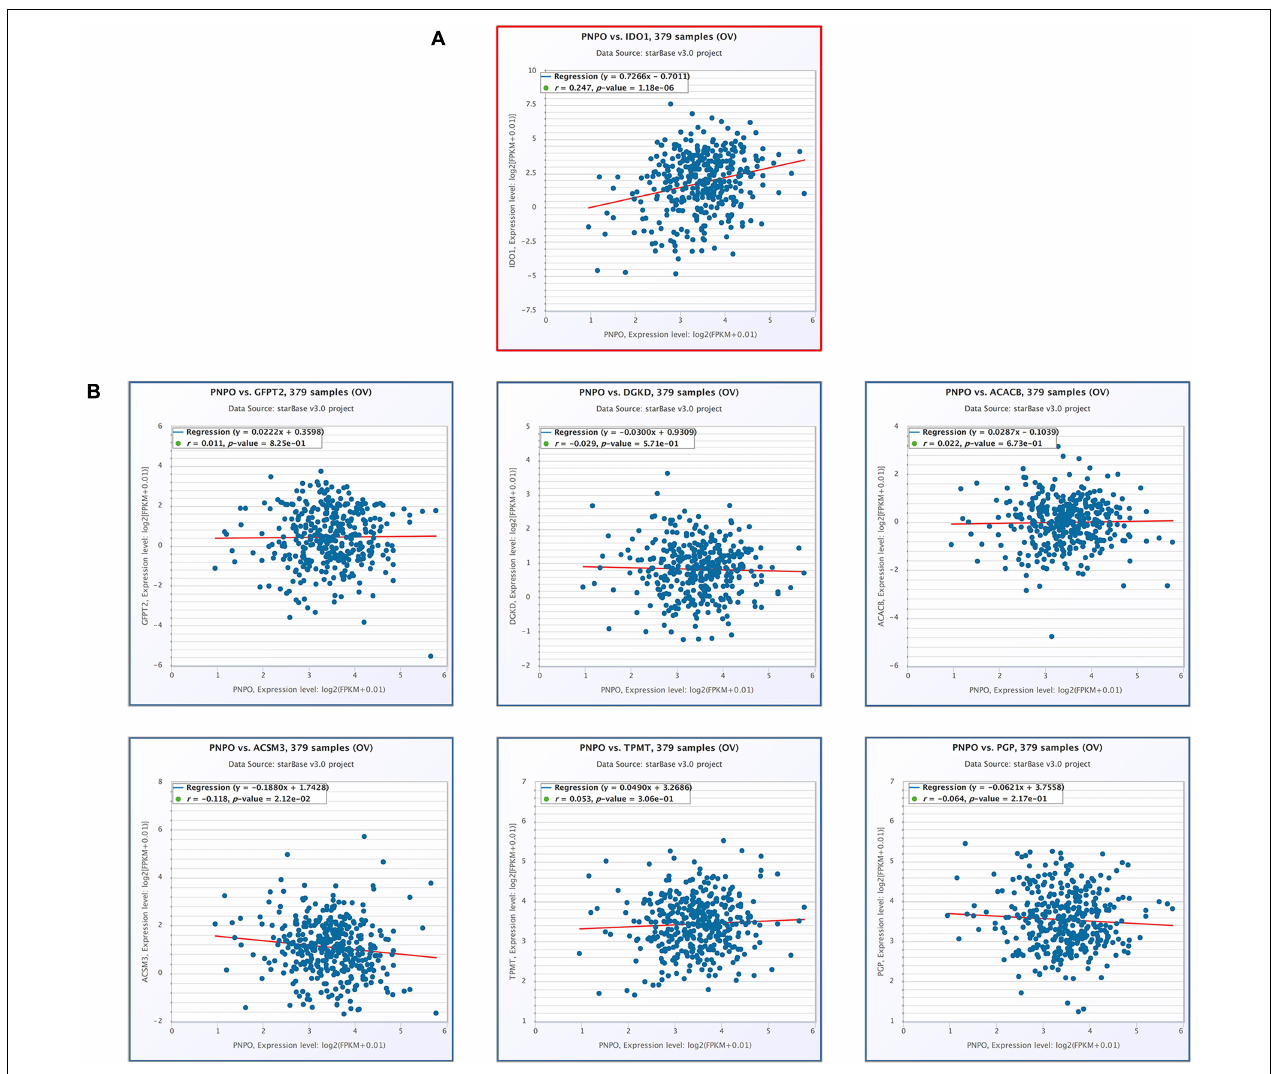
FIGURE 8 | The correlation of seven hub genes with the expression of PNPO in the TCGA-OC cohort (starBase). (A) The positive correlation between PNPO and IDO1. (B) The correlation between the expression of PNPO and the other six hub